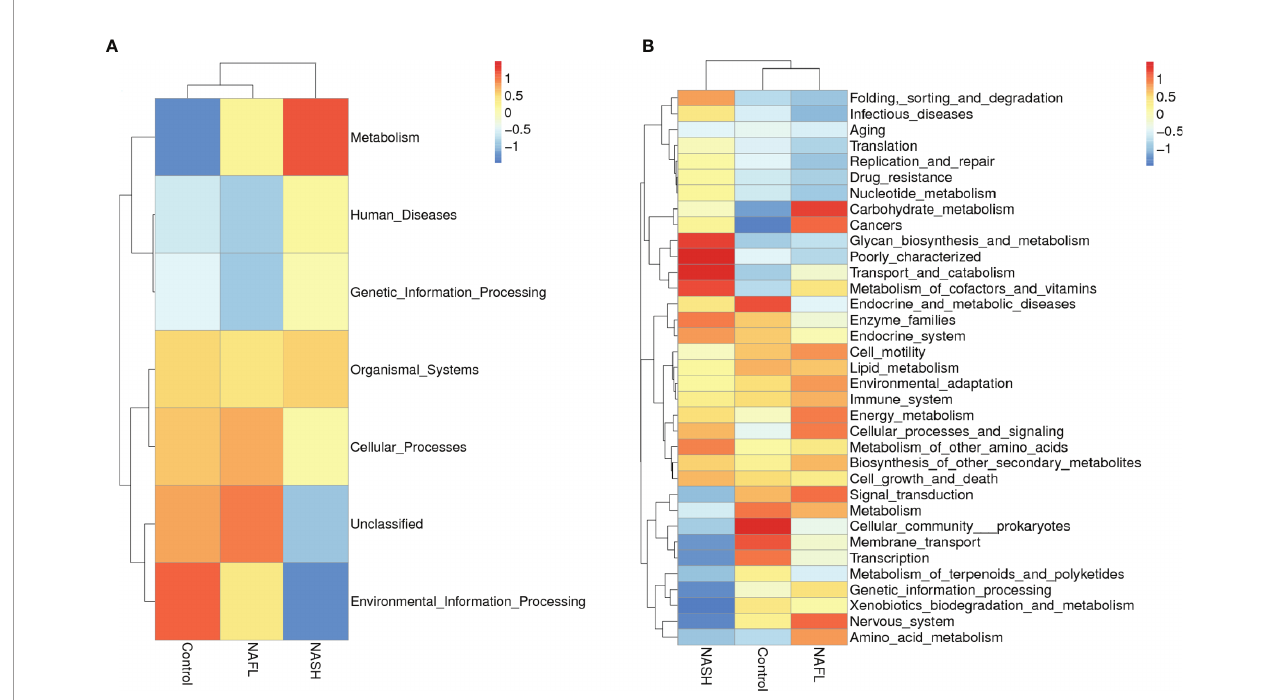
FIGURE 3 | Cluster heatmap of annotated function by Tax4Fun. (A) The main functions and (B) the metabolism functions. In the fi gure, the horizontal ordinate represents the sample information and species annotation information; the cluster trees on the left and the top are species clustering and sample clustering, respectively; middle heat map matching is the Z -value. Z -Value is obtained after standardized treatment of relative abundance of species. It is the difference between the relative abundance of a sample in this classi fi cation and the average relative abundance of all samples in this classi fi cation divided by the standard deviation of all samples in this classi fi cation. NAFL, nonalcoholic fatty liver; NASH, nonalcoholic